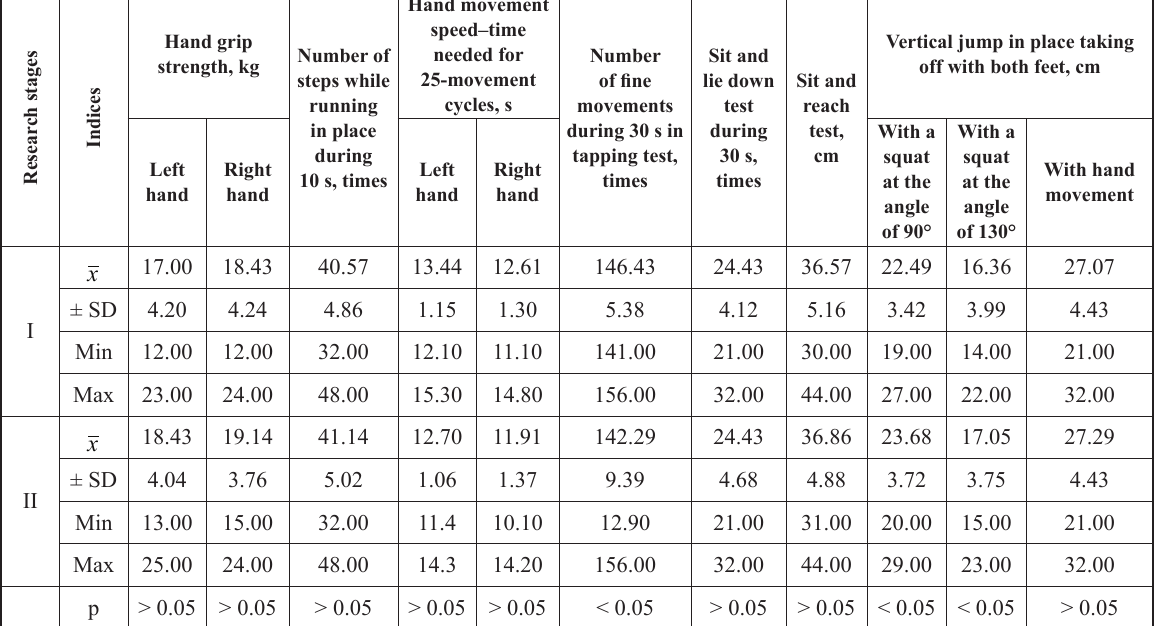
Table 5. Changes in the indices of athletic fitness for junior boys in sports dancing Hand grip strength, kg sI ag e s t ce h rc nd i a s e R e Left Right hand hand